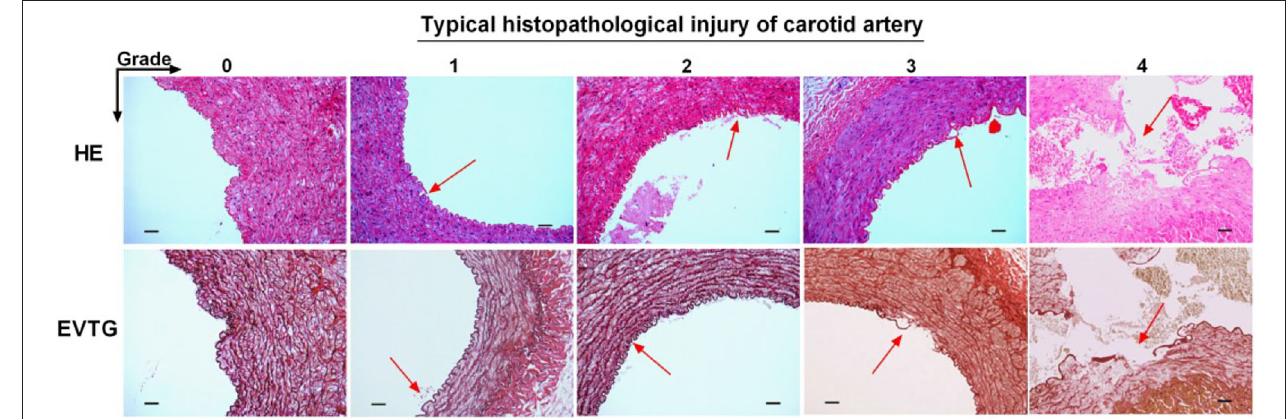
FIGURE 3 | Histopathological injury of carotid artery. The tissues were embedded in paraffin and cut into five 1-cm-thick coronal blocks from distal to proximal with regard to arterial blood flow. Then five serial 4- µ m-thick sections were cut from every block still in a distal-to-proximal direction (25 sections per dog) and stained with hematoxylin-eosin and Elastic Verhoeff’s Van Gieson stain. The sections were examined under light microscopy (magnification 200x). The arrow represents the typical histopathological injury of carotid artery. Scale bar = 200 µ